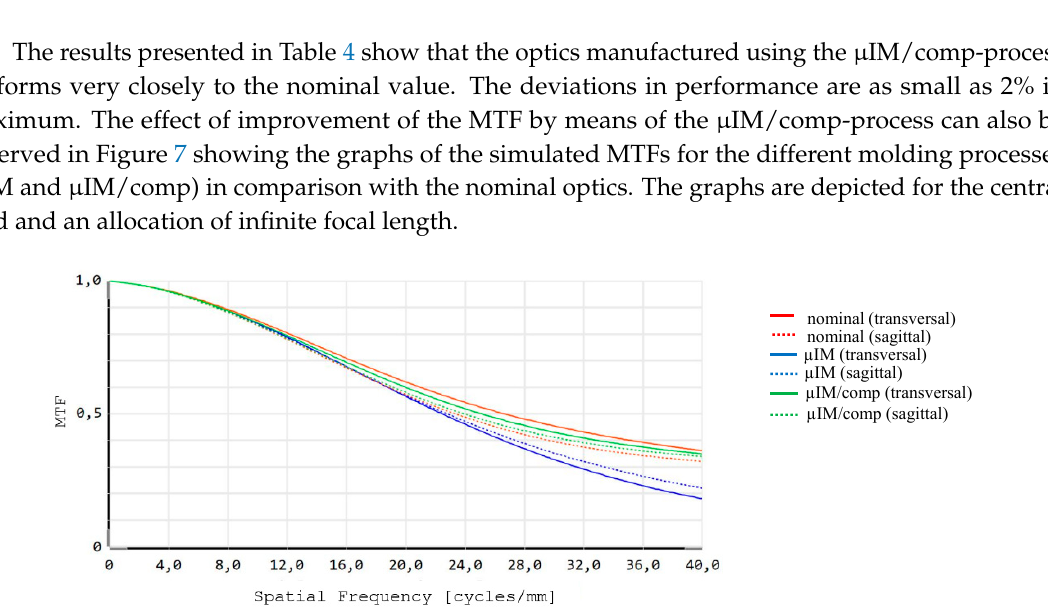
Figure 7. MTF derived with the compensated injection-molded freeform optics included (green) in comparison with Figure 3.